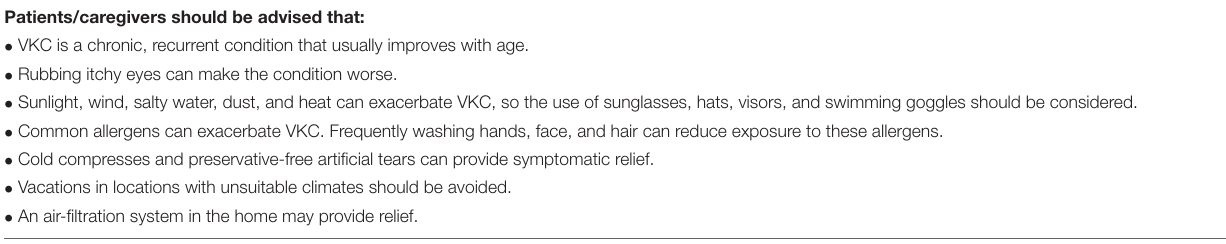
TABLE 3 | Summary of patient education and preventive measures in the management of VKC. Patients/caregivers should be advised that: